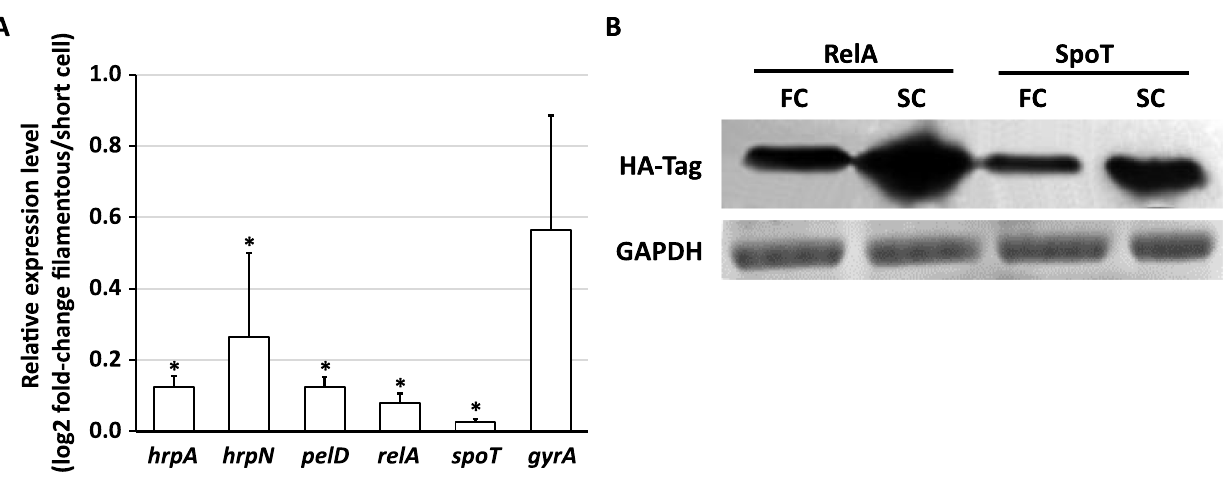
Fig 5. Expression of virulence and ppGpp biosynthesis genes in the filamentous and short cells of D . dadantii . (A) Relative mRNA abundance of hrpA , hrpN , pelD , relA , spoT and gyrA (filamentous cells/short cells) quantified by qRT-PCR. (B) Western blot analysis of RelA and SpoT protein levels in filamentous and short cells D . dadantii filamentous and short cells were obtained from the P2 position of infected potato tubers after 48 h of incubation. The short cells and the filamentous cells were separated by sucrose gradient centrifugation as illustrated in S2 Fig. rplU was used as an endogenous control for qRT-PCR. Error bars indicate standard errors of the means. Asterisks indicate statistically significant differences of the means ( P < 0.05 by Student’s t test). HA tag was inserted at the 3’ end of the ORFs of relA and spoT . RelA and SpoT proteins were detected by α -HA antibody. GAPDH stained with Coomassie blue was used as the loading control. The experiments were repeated three times with similar results.